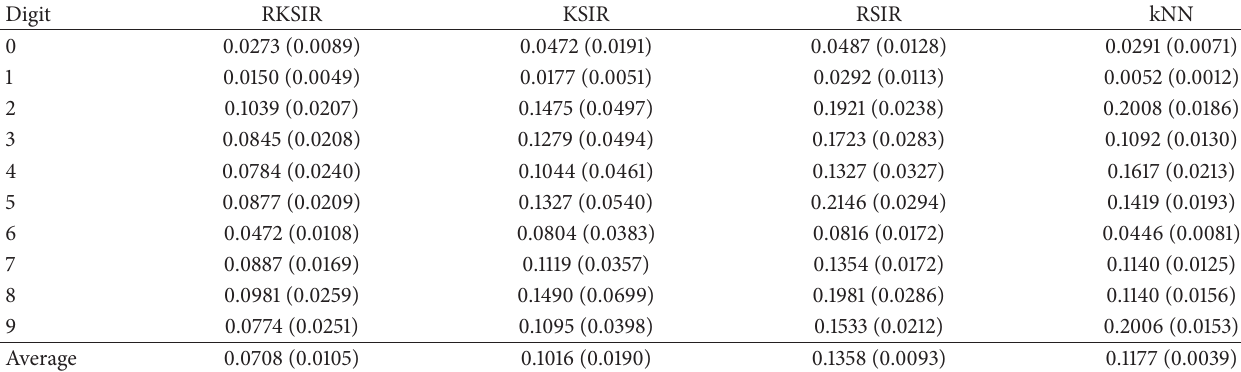
Table 1: Mean and standard deviations for error rates in classification of